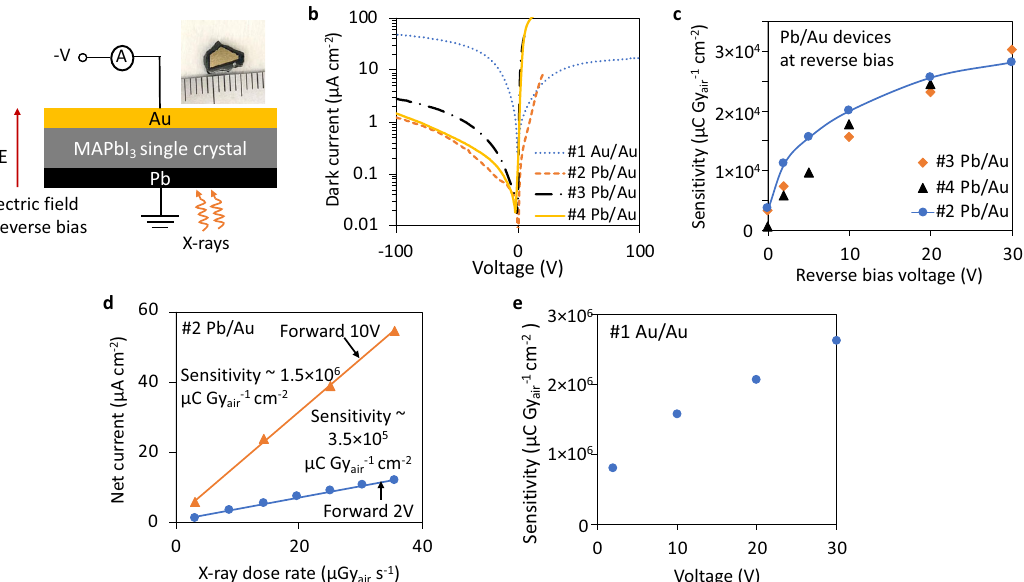
Fig. 3 Sensitivity comparison of MAPbI 3 single crystal devices in different working mode. a Experiment setup for reverse bias operation of the Pb/Au devices and the hole dominantly induced signal collection. b Dark I – V characterization of the devices. c Sensitivity of the reversely biased Pb/Au photodiode. d Sensitivity of the forward biased #2 Pb/Au photodiode. e Sensitivity of the Au/Au